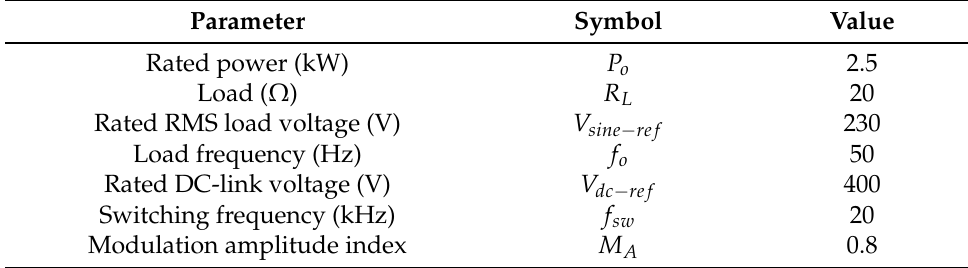
Figure 3. Schematic of the multi-converter system with a common DC-bank. Table 1. Specifications of the output load.